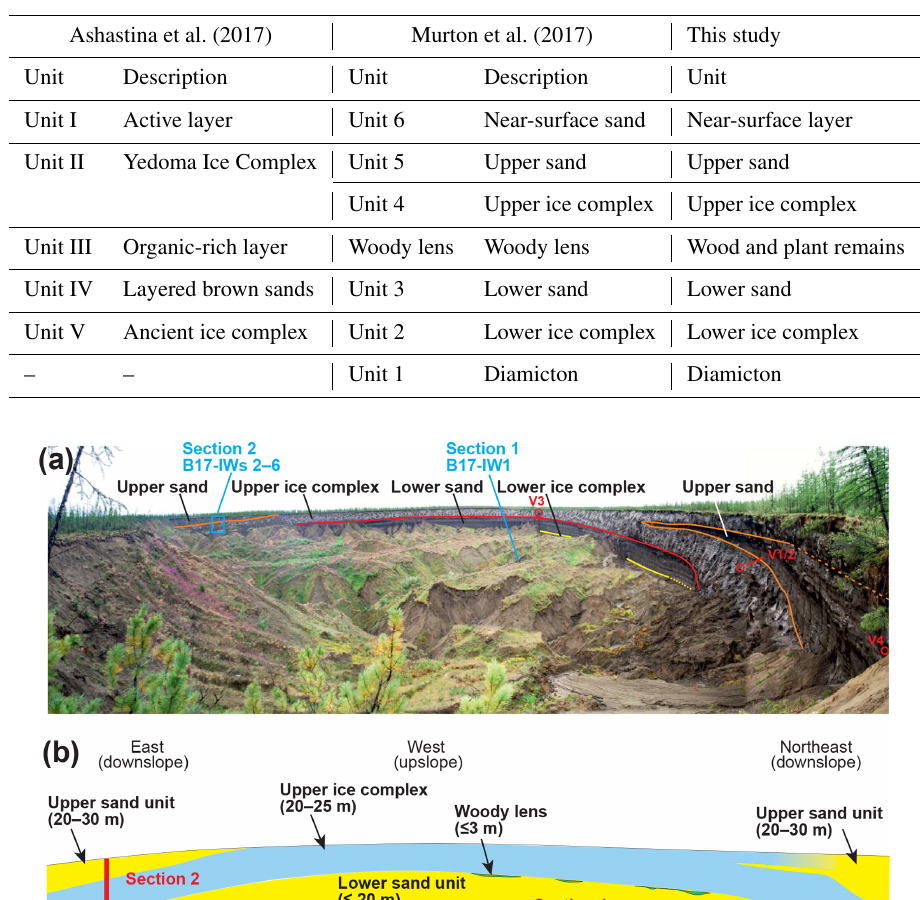
Table 1. Cryostratigraphic units of the Batagay megaslump as presented by Ashastina et al. (2017) and Murton et al. (2017) and the reconciled stratigraphic framework used in this study and proposed for future studies.